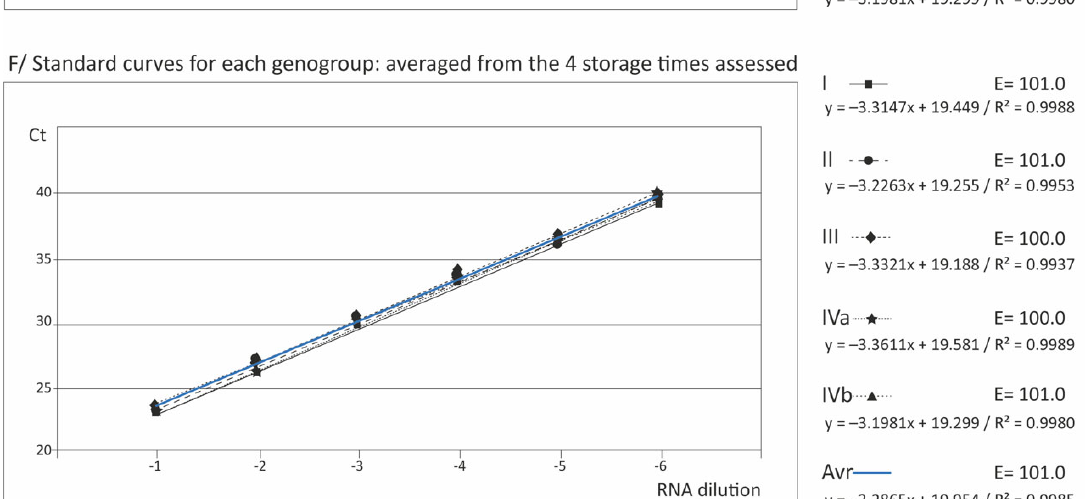
Figure 1. Standard curves with RT ‐ qPCR. For each genogroup, the standard curves obtained with the macroarray applying RT ‐ qPCR immediately after its preparation (0 h) and after the three storage times assessed (one day, one week, and three months) are shown. The equation of each curve ( 1 ), its reliability in terms of coefficient of determination (R 2 ) ( 2 ), and the efficiency of the amplification (E) ( 3 ), calculated from the formula E = 10 − 1/S − 1 (where S is the slope of the regression line), are indicated. For each genogroup, the average line (averaged from the 4 storage times) is also shown ( 4 ).